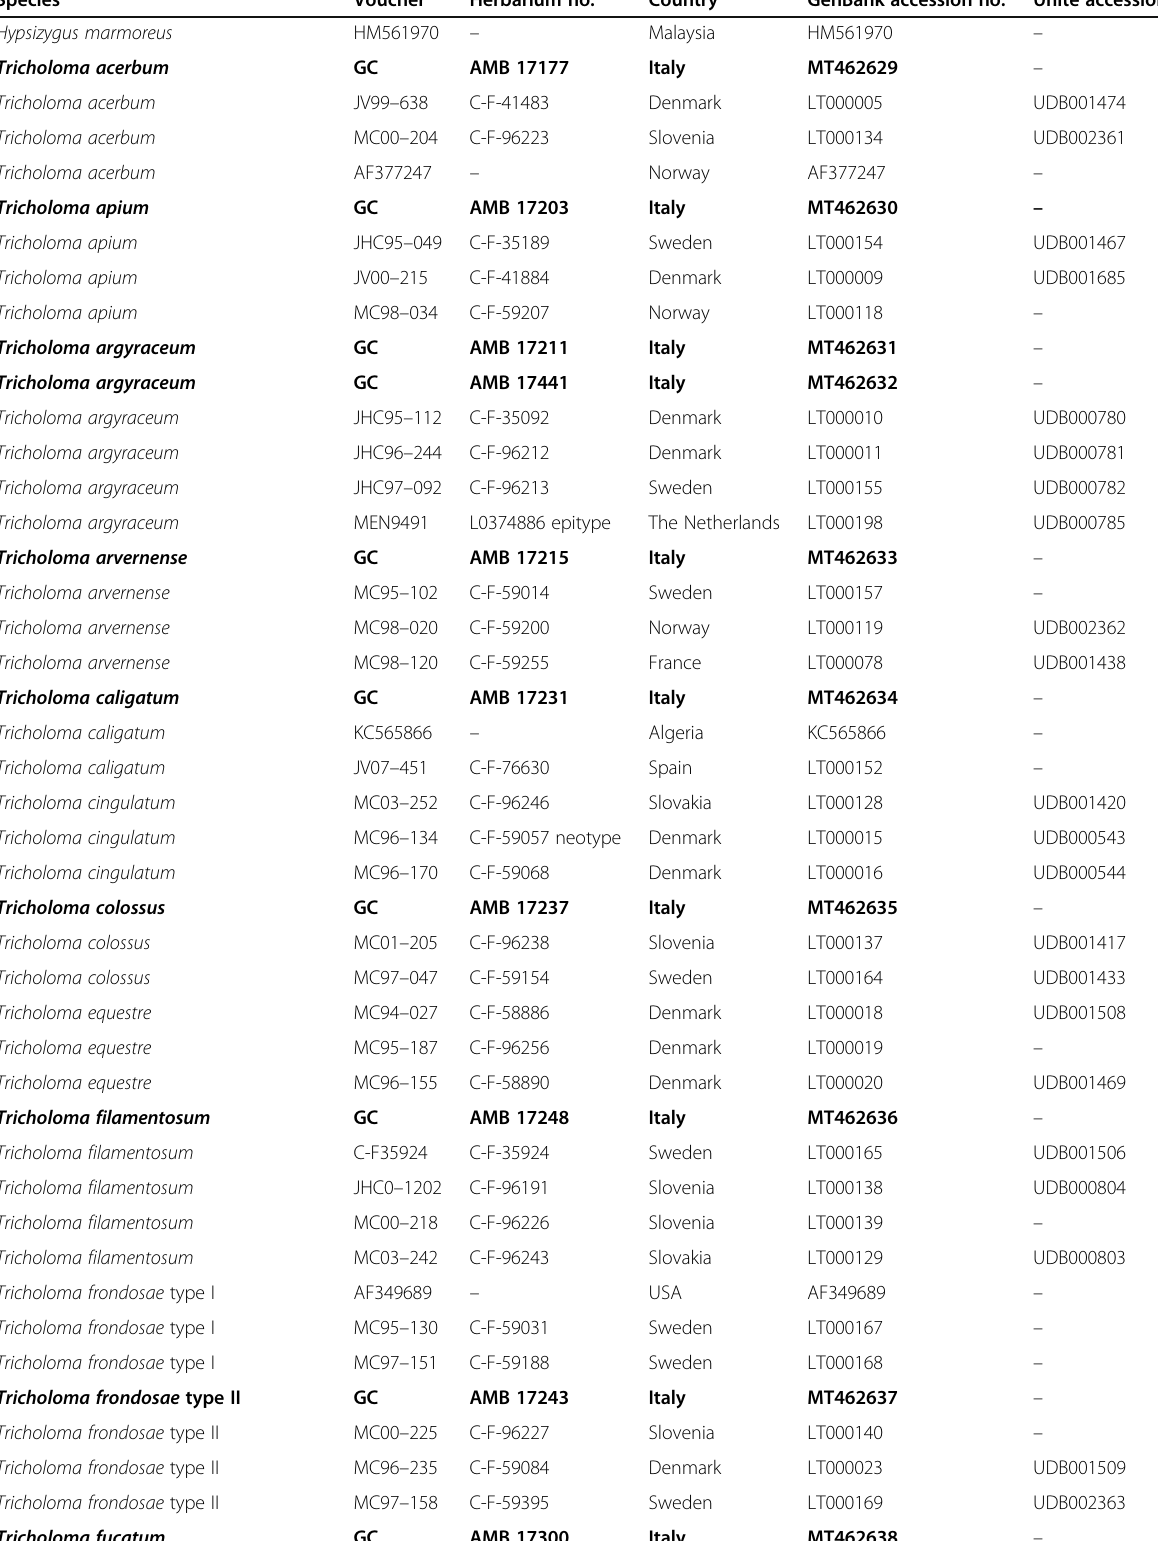
Table 2 Collections used for the phylogenetic analysis. Newly sequenced collections are in bold